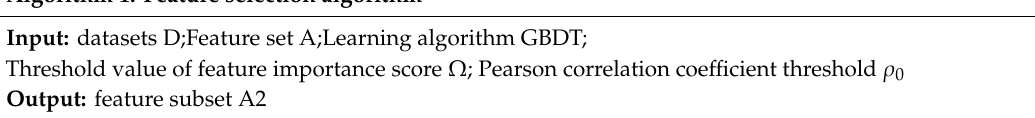
Algorithm 1: Feature selection